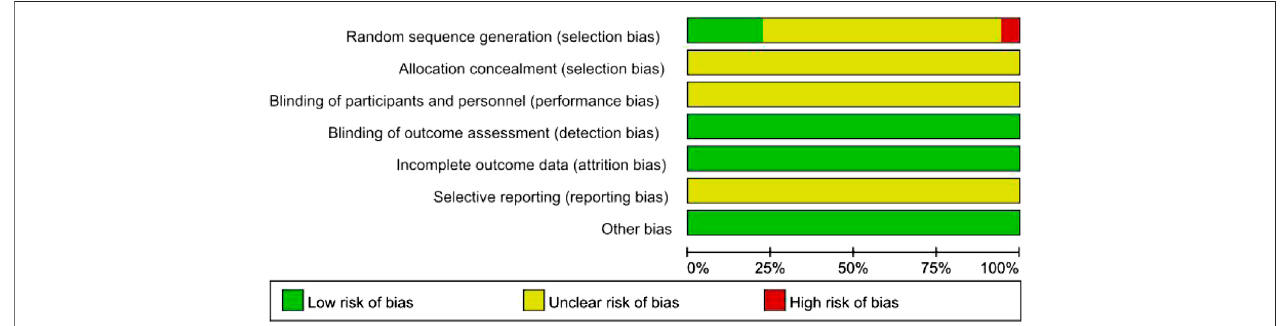
FIGURE 2 | Risk-of-bias graph.